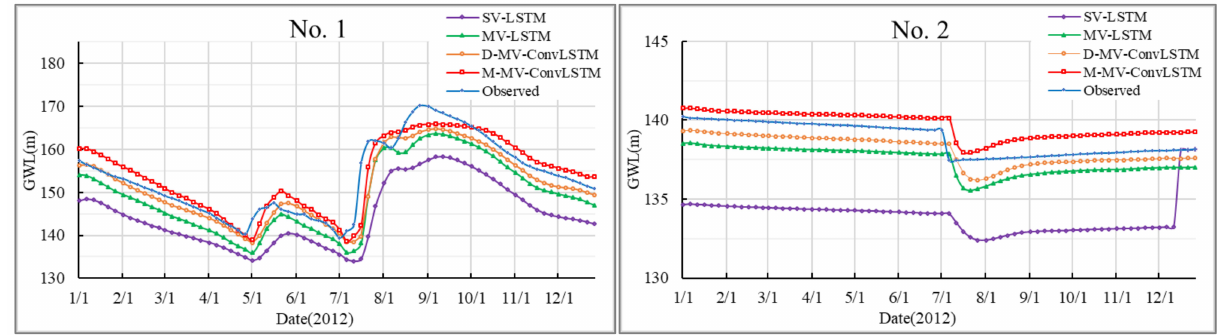
Figure 8. Modeling simulation results obtained for wells No. 1 and No. 2 in the four